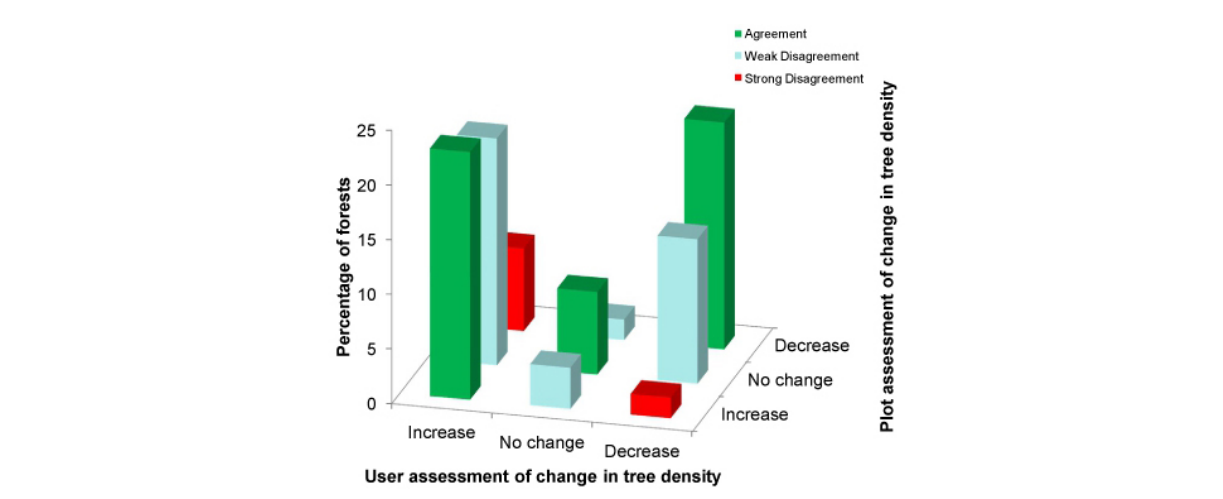
Fig. 2. Plot assessment of change in tree density vs. user assessment of change in tree